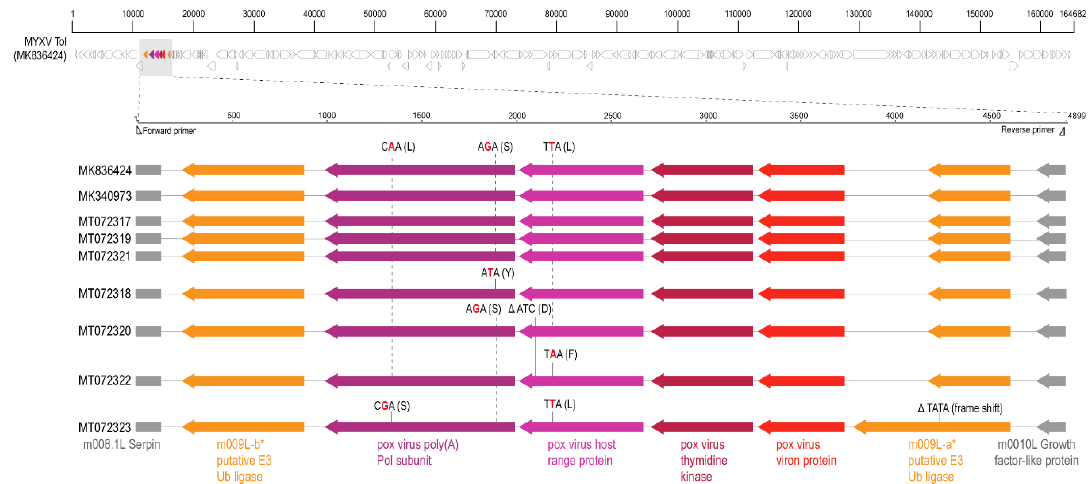
Figure 1. Myxoma virus genome schematic with recombinant region highlighted. The variations identified in the recombinant gene cassette of the sequenced MYXV-Tol variants from various samples are summarized in reference to the MYXV-Tol GenBank accession. SNPs are shown with red highlighted nucleotide and the encoded amino acid in brackets. Deletions are shown with ∆ symbol and the deleted amino acid in brackets.